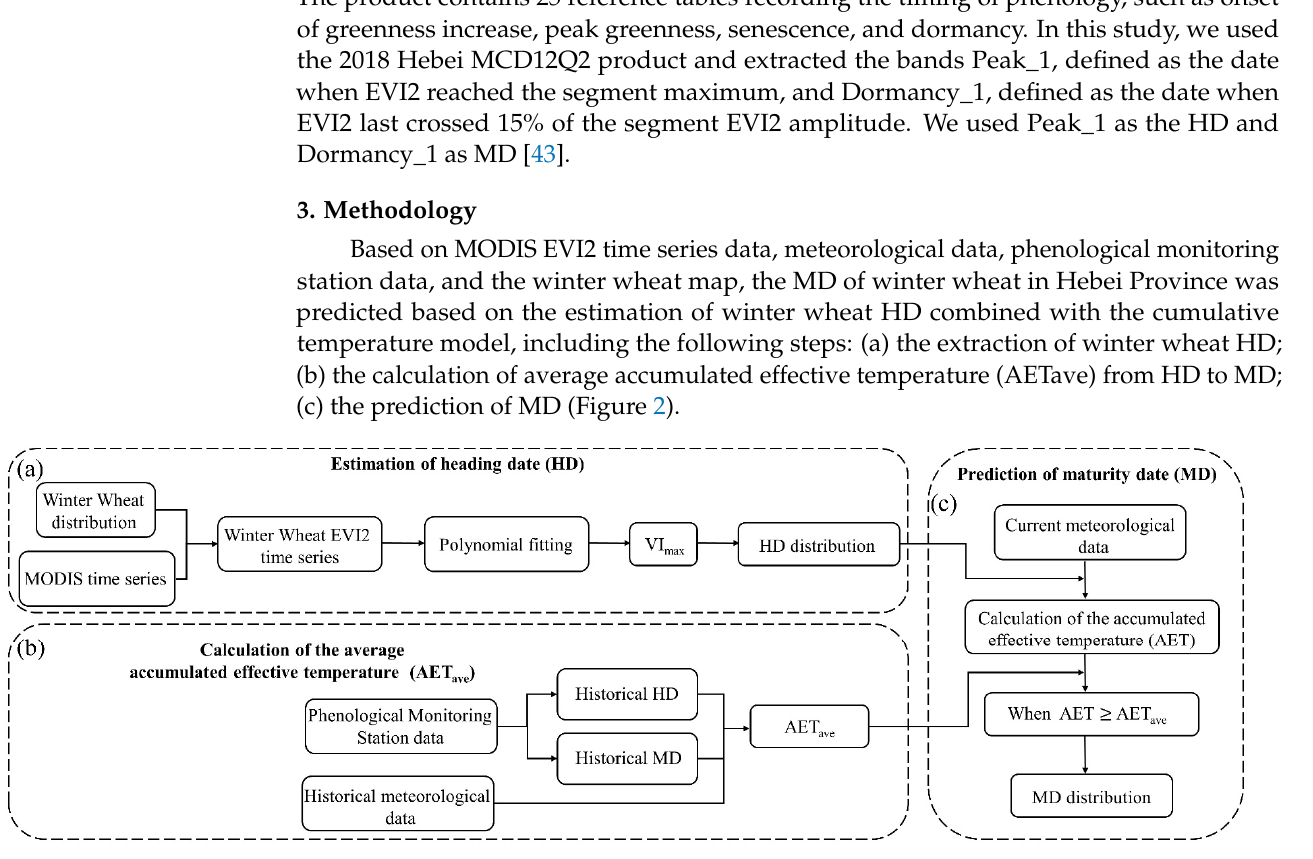
Figure 2. Workflow of the prediction of maturity date (MD). ( a ) Estimation of heading date (HD). ( b ) Calculation of average accumulated effective temperature (AETave). ( c ) Prediction of maturity date (MD).